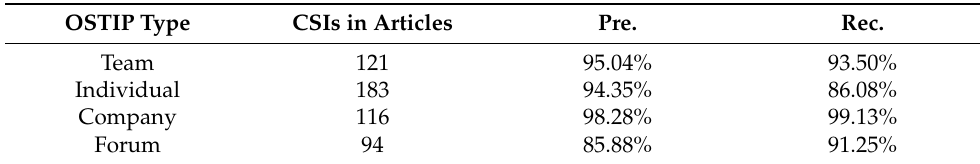
Table 10. Accuracy of CSI